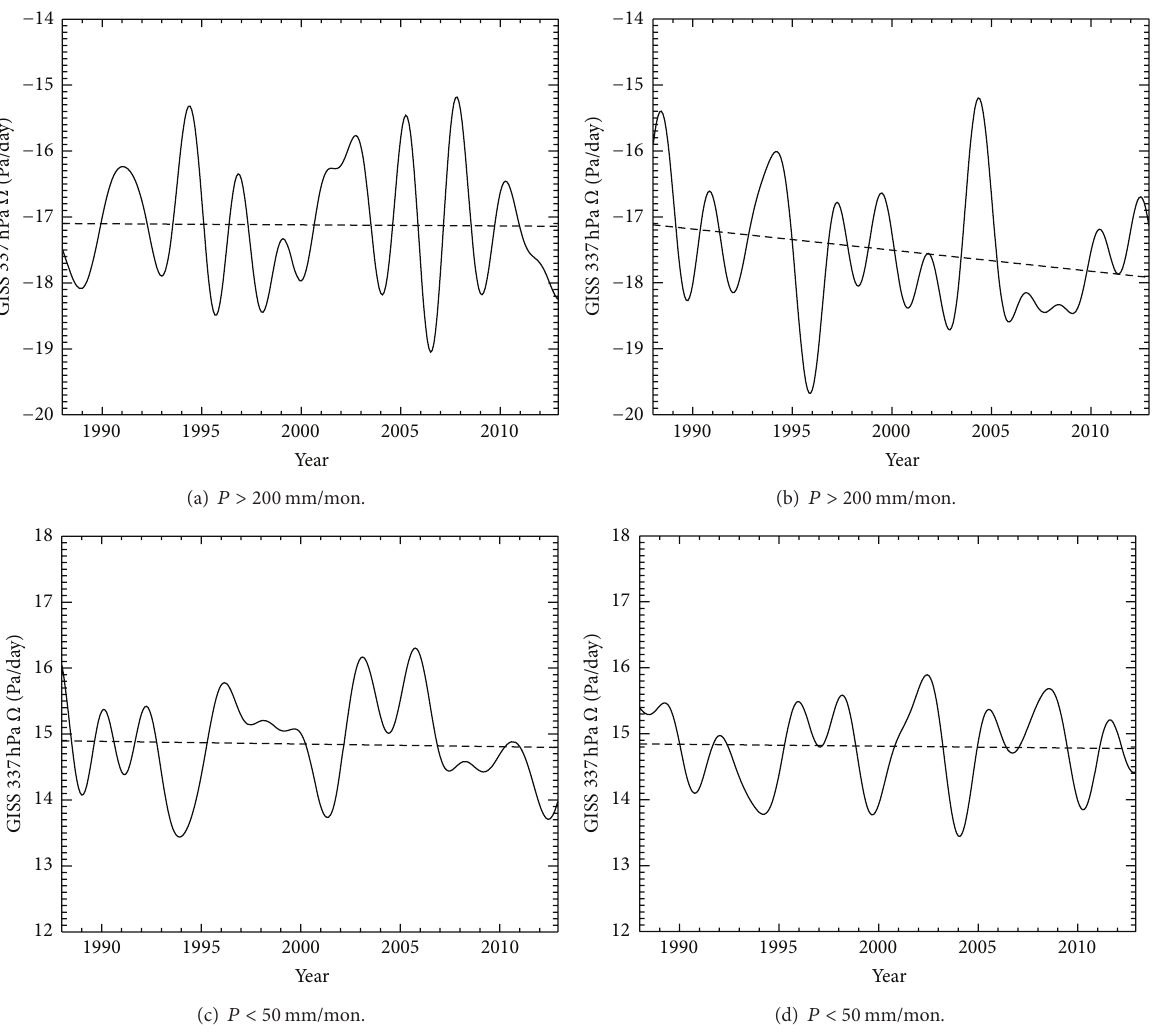
Figure 5: Low-pass filtered time series for 337 hPa vertical pressure velocity Ω ( 𝑑𝑃/𝑑𝑡 ) from GISS/HYCOM. (a) Ω over high-precipitation area ( 𝑃 > 200 mm/mon.) from the control simulation (solid line) and trend (dashed line). (b) Ω over high-precipitation area from the historic simulation (solid line) and trend (dashed line). (c) Same as (a) except for areas with precipitation < 50 mm/mon. (d) Same as (b) except for areas with precipitation < 50 mm/mon.